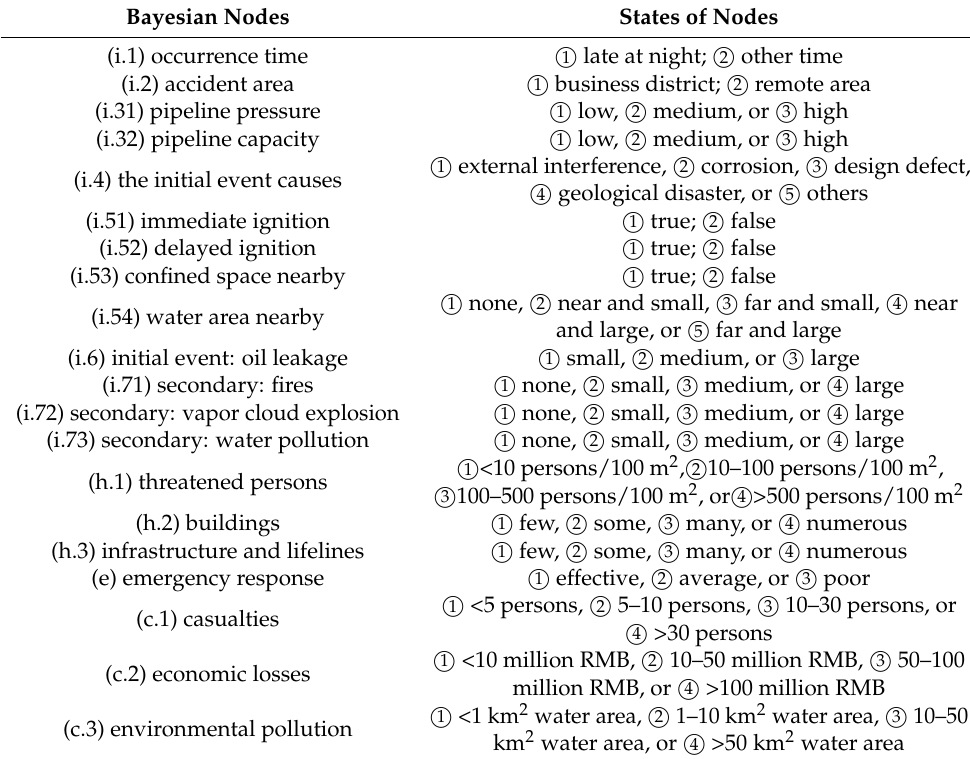
Table 2. The nodes in a BN risk analysis model for oil pipeline accidents. Bayesian